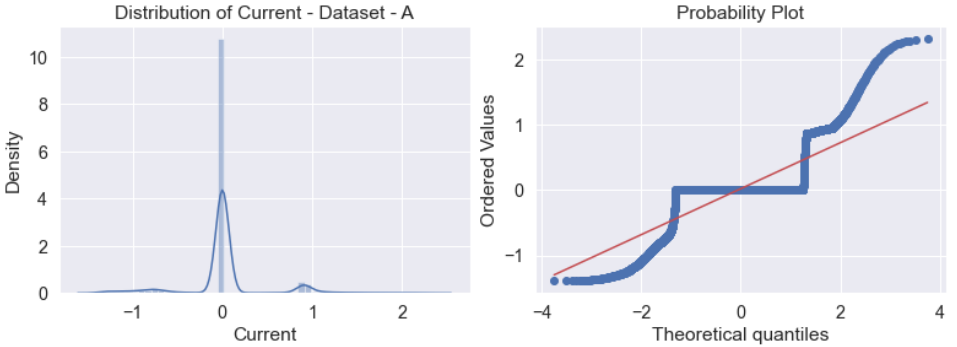
Figure 14. Density and probability plots of Dataset